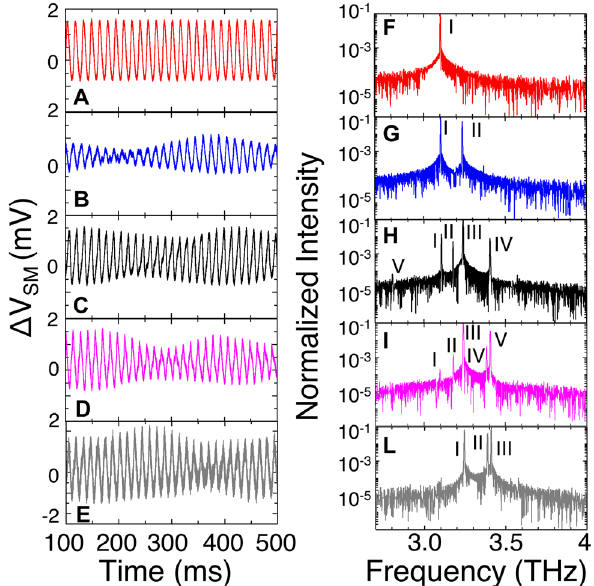
Figure 3: (A – E) Time evolution of the self-mixing traces collected with a fast oscilloscope (Zurich instruments, UHFLI Lock-in ampli- fier), while varying the position of the movable FTIR mirror and while driving the QCL with different currents: I = 236 mA; I = 250 mA; I = 260 mA, I = 275 mA, I = 284 mA (from top to bottom). (F – L) Corresponding FTIR emissionspectra measuredin rapid scan mode, while driving the random laser at a heat sink temperature of 10 K, and with currents I = 236 mA; I = 250 mA; I = 260 mA, I = 275 mA, I = 284 mA (from top to bottom), with a resolution of 0.075 cm − 1